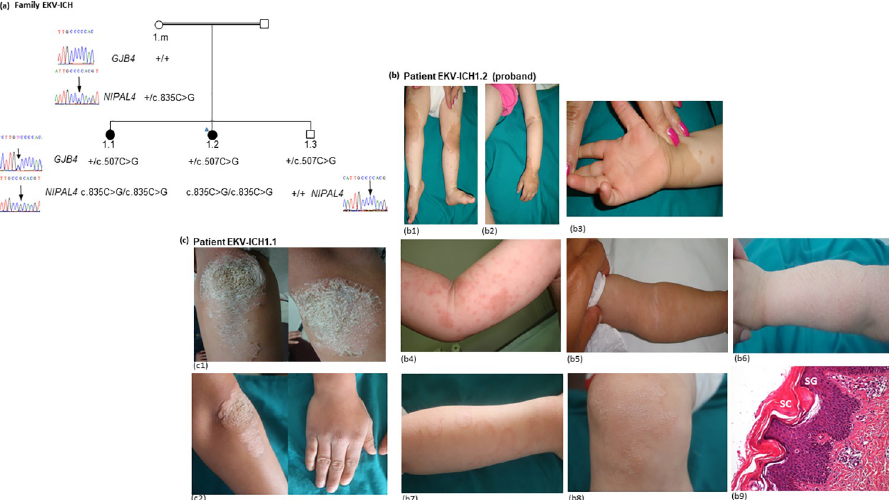
Fig 1. Pedigree, clinical and histological features of Erythrokeratodermia variabilis (EKV) in family EKV-ICH1. (a) Pedigree of the family segregating with autosomal recessive inheritance of EKV phenotype. The proband (EKV-ICH1.2) is indicated with a blue triangle. The sequence chromatograms illustrate the genotypes of tested family members for GJB4 and NIPAL4 genes. The likely polymorphism c.507C > G, (C169W) within the GBJ4 gene (RefSeq NM_001005752) is identified at heterozygous state in both affected sisters (EKV-ICH1.1, 2) and the unaffected brother (EKV-ICH1.3). The c.835C > G (p.Pro279Ala) mutation within the NIPAL4 gene (RefSeq NM_001099287) is identified at homozygous state in both affected sisters (EKV-ICH1.1, 2). Pedigree shows the cosegregation of the c.835C > G (p. Pro279Ala) mutation with EKV phenotype in a recessive mode. (b) The proband showed symmetric, well demarcated, brownish hyperkeratotic plaques localized on the knees, the feet (b1) and the dorsa of the hands (b2, b3) at the age of 18 months (first physical examination). Note the circinate borders of the erythematous plaques and the slight erythematous hyperkeratotic palmar keratoderma (b3). At the second visit, two weeks later, diffuse, migratory, figurative, erythematous spots and patches on the trunk and extremities (b4). Note the progression of the hyperkeratotic plaques and the variability of the distribution of hyperkeratotic plaques between the different clinical examination one month later (b5, b6). Widespread, large, adherent scale on extremities and trunk suggestive of ichtyosiform-lesions (b7). Two years later, fixed hyperkeratotic lesions on the forearms, knees, and dorsa of the hands (b7, b8). Histological findings from skin biopsy taken from the proband EKV-ICH1.2 showed hyperkeratosis associated with a compact, thickened stratum corneum (SC), hypogranulosis with a mild thinning stratum granulosum (SG) layer, papillomatosis, dilated follicles containing large keratin plugs, and a mild perivascular lymphocytic infiltrate (b9) (HE, x100). (c) The patient (EKV-ICH1.1) showed symmetric thick hyperkeratotic psoriasiform plaques over the knees at the age of 11 years. Two years later, symmetric hyperkeratotic squamous plaques with erythematous circinate borders on the elbows and erythematous and squamous plaques on the dorsa of the hands.